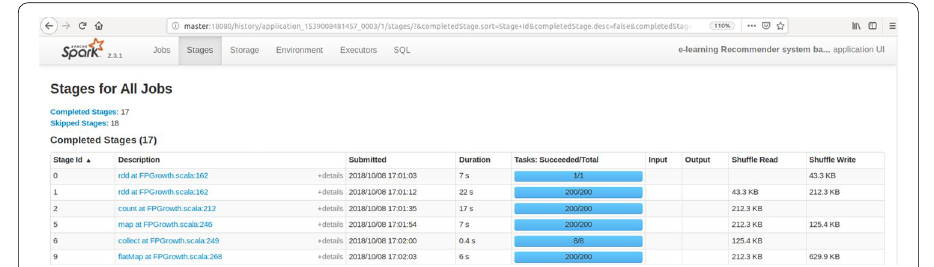
Fig. 10 Spark Web UI: It displays useful information about the execution of Spark application which includes list of jobs, size memory usage, the running executors, and environmental information